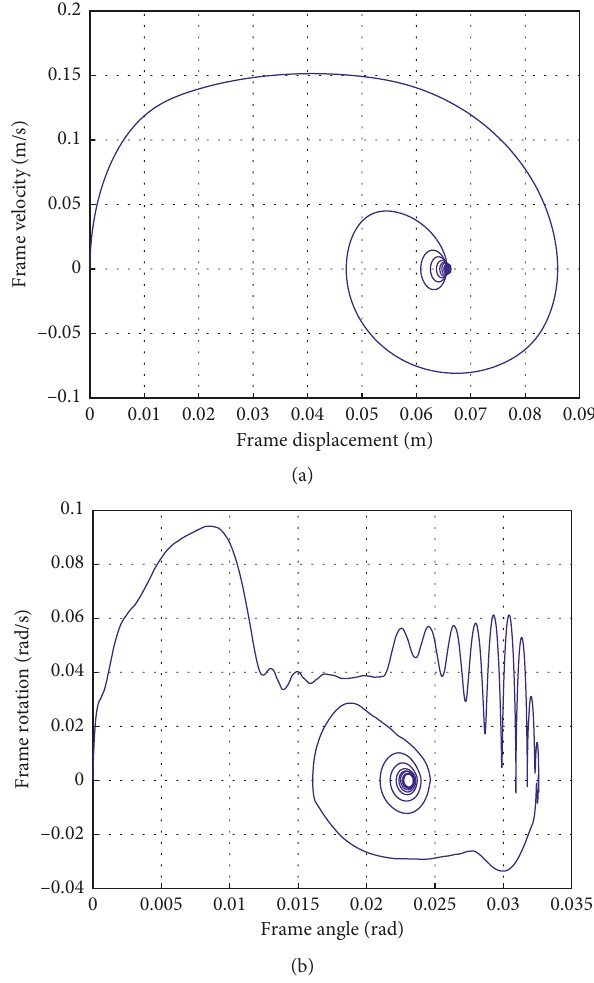
Figure 12: Displacement-velocity phase plane (a) and angle-ro- tation phase plane